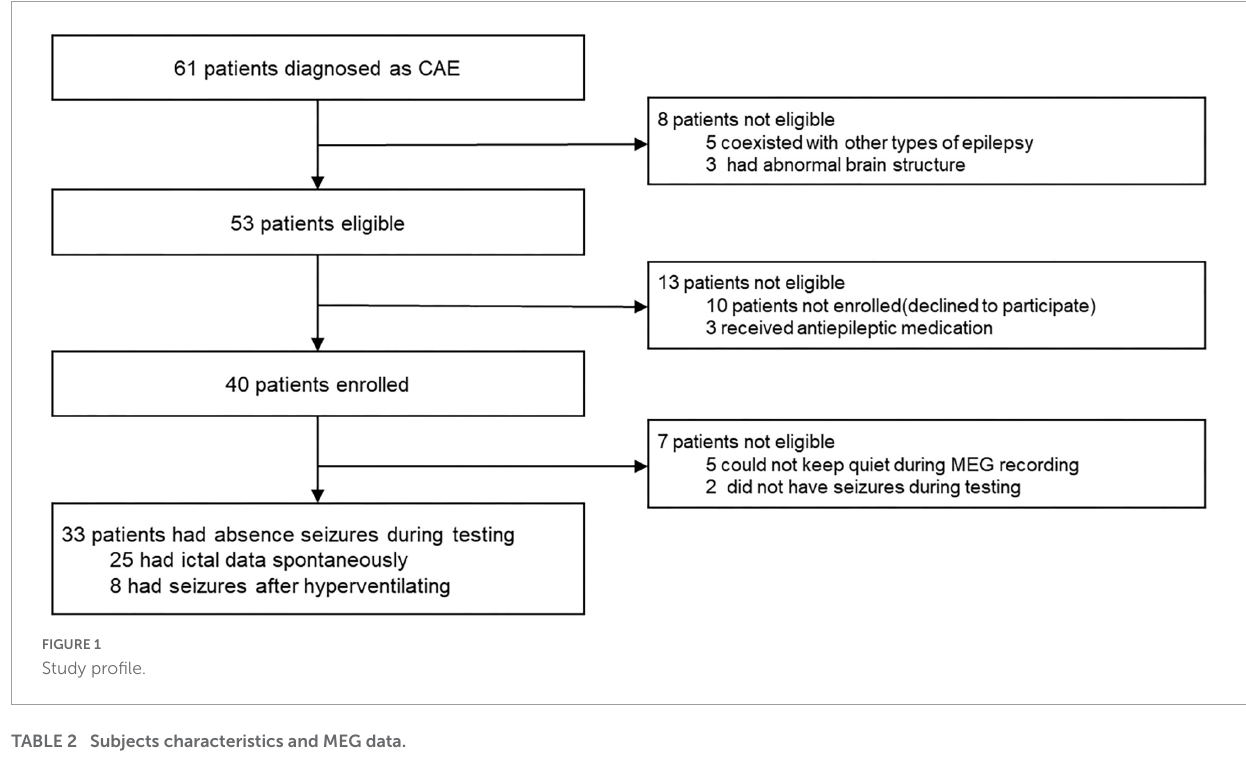
TABLE 2 Subjects characteristics and MEG